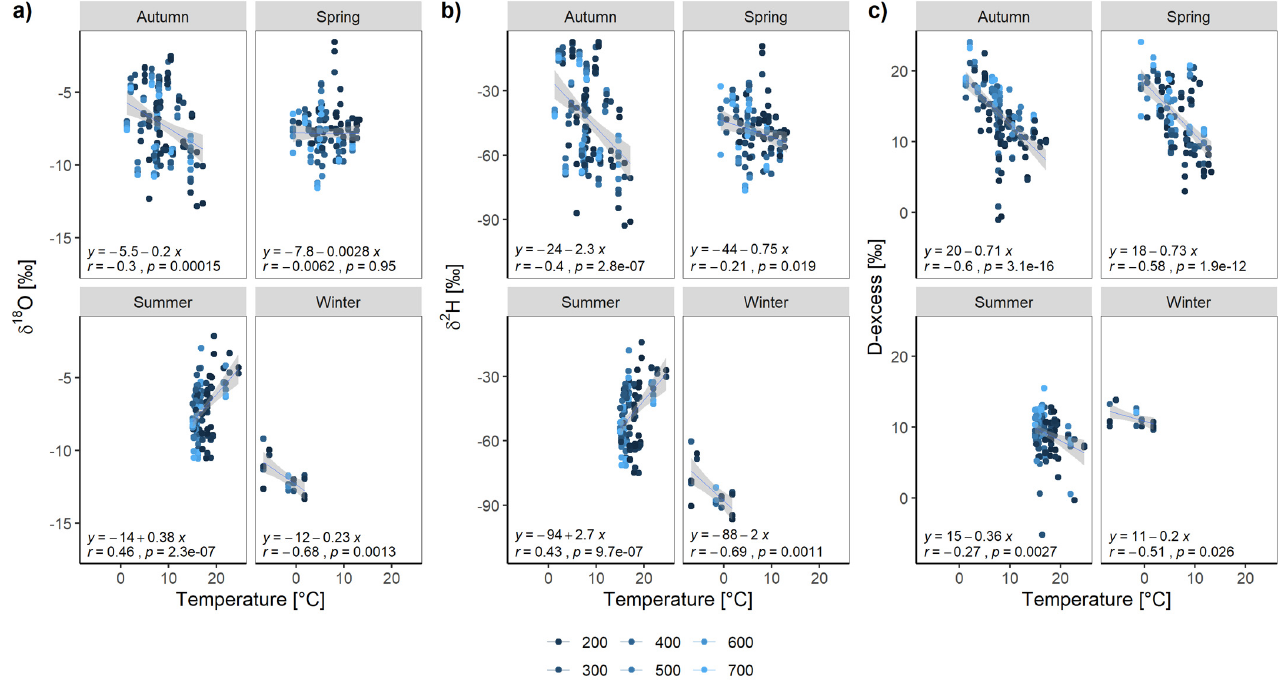
Figure 6. The isotopic values of δ 18 O ( a ), δ 2 H ( b ), and D-excess ( c ) of precipitation with temperature along a representative elevation transect separated by seasons. The grey shadings represent the 95% confidence interval of the linear regression lines.